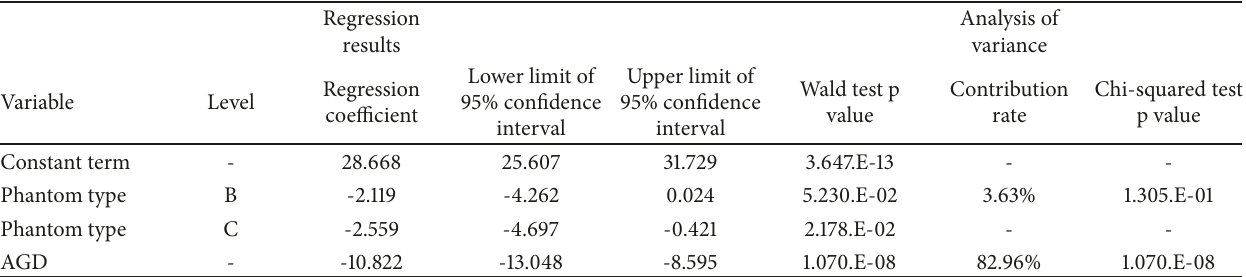
Table 8: Results of multivariate linear regression analysis using CNR as the objective variable and phantom type and AGD as the explanatory